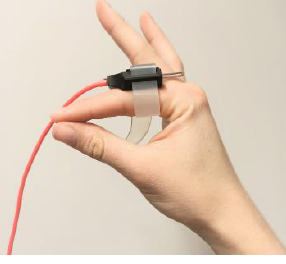
Figure 1. Accelerometer positioned at the base of the right index finger.